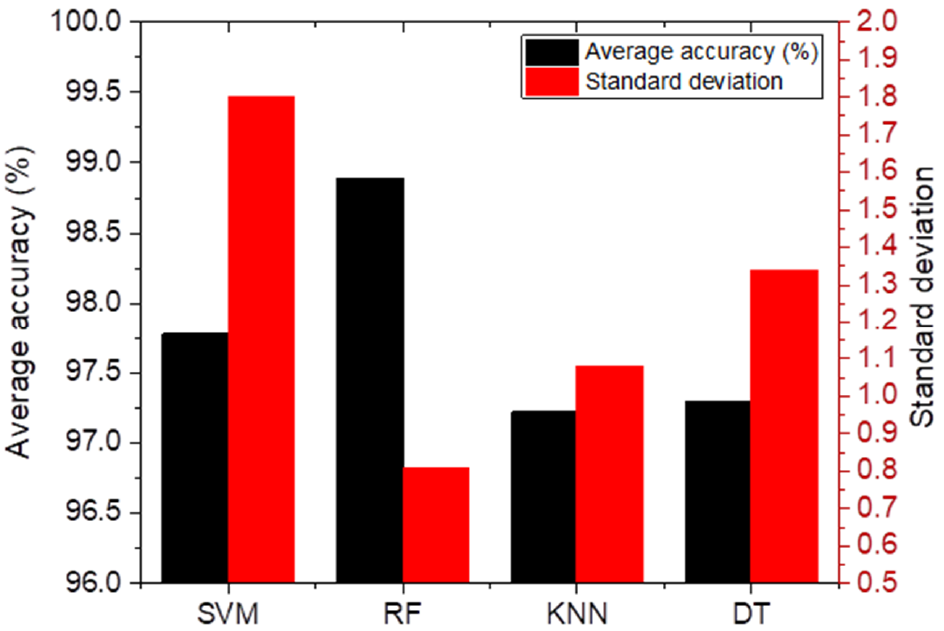
Figure 9. Average accuracies of 10-fold cross validation over training data and their standard deviation for the four developed models.